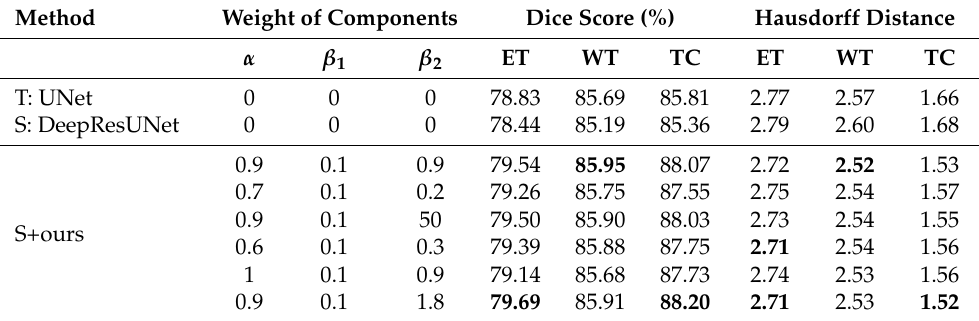
Table 5. The effects of component weights represented by hyperparameters α , β 1 and β 2 in Equation (6). The values in bold are the highest Dice score and the lowest hausdorff distance in their columns. As shown in the first two rows, when these weights were set to 0, as with the original segmentation network, the training process would be